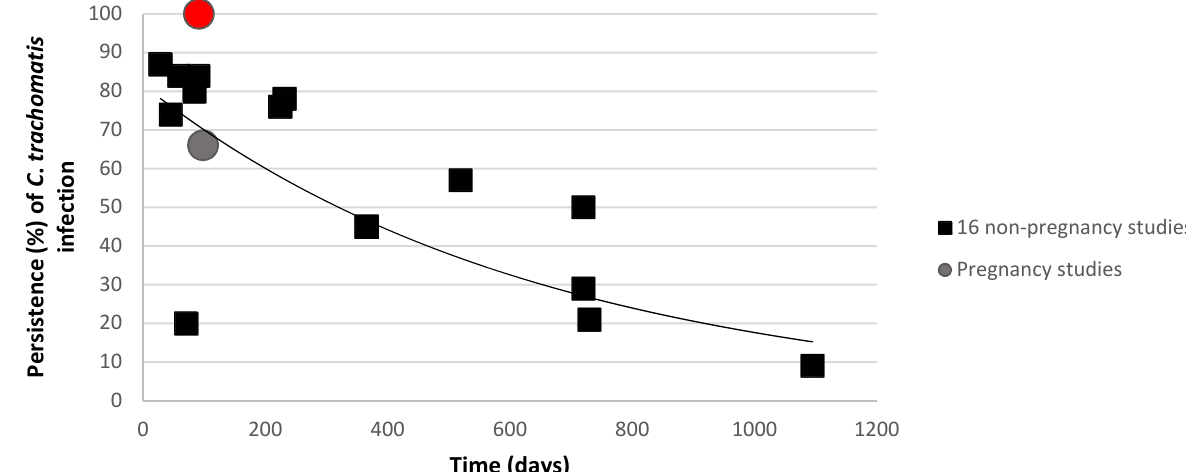
Figure 4. Urogenital C. trachomatis presence in women during follow-up. Percentages of C. trachomatis infected women are described by Golden et al. and Geisler et al. ■ are compared with two pregnancy studies (Sheffield et al. ● and the present study ● ) [14,17,36]. The curve shows the trend as calculated by the sixteen non-pregnant studies.